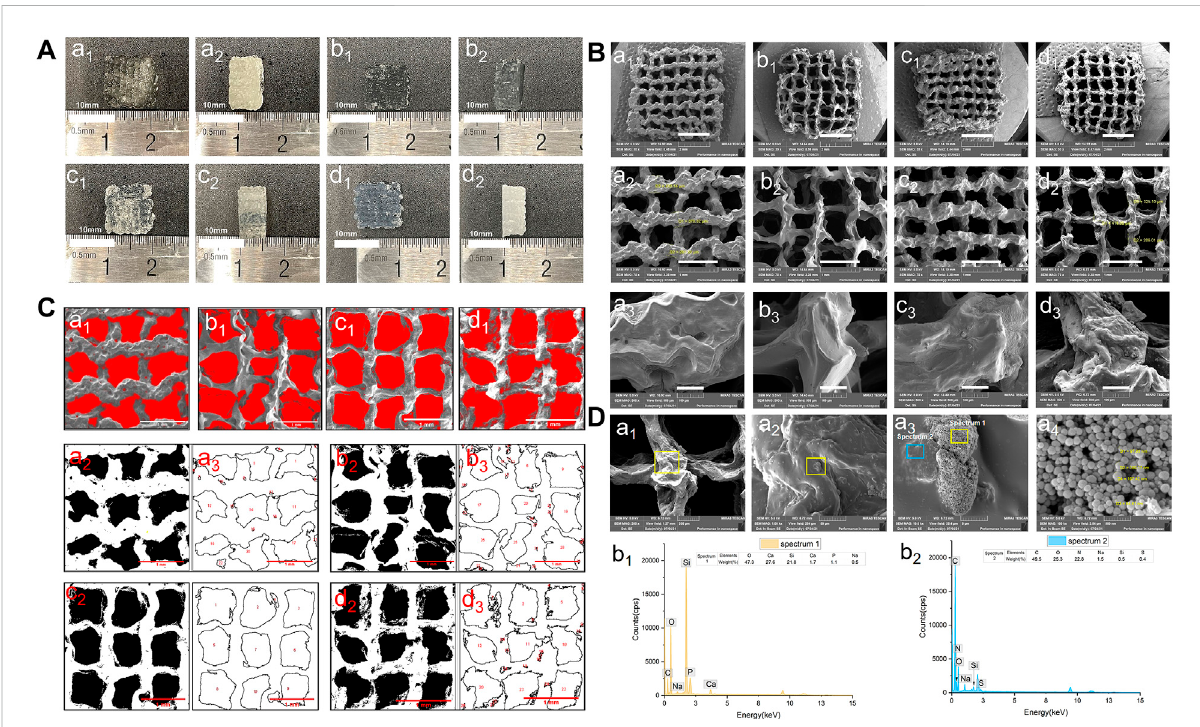
FIGURE 3 Morphology of 3D-printed mesoporous BG/GelMA macropore scaffolds. (A) Top and side-views of the macro morphology. a1 – a2) 0% BG group;b1 – b2)1%BGgroup;c1 – c2)5%BGgroup;d1 – d2)10%BGgroup; (B) Representativescanningelectronmicroscopicimagesat30x,75x,500x magni fi cation. a1 – a3) 0% BG group; b1 – b3) 1% BG group; c1 – c3) 5% BG group; d1 – d3) 10% BG group; (C) and pore sizes of scaffolds. a1 – a3) 0% BG group;b1 – b3)1%BGgroup;c1 – c3)5%BGgroup;andd1 – d3)10%BGgroup;Note:allthedarkestregionsoftheimagebecamered;contoursof the pores were traced and coded (from a2, a3 to d2,d3); (D) The representative SEM images of the 10% BG group scaffolds from a1) 200x; b1) 1.0kx; c1) 10.0kx to d1)100kx and SEM-energy-dispersive X-ray spectroscopy (EDS) analysis of two lumps in a3. b1) graph of EDS analysis of the yellow box area in panel a3; b2) graph of EDS analysis of the blue box area in panel